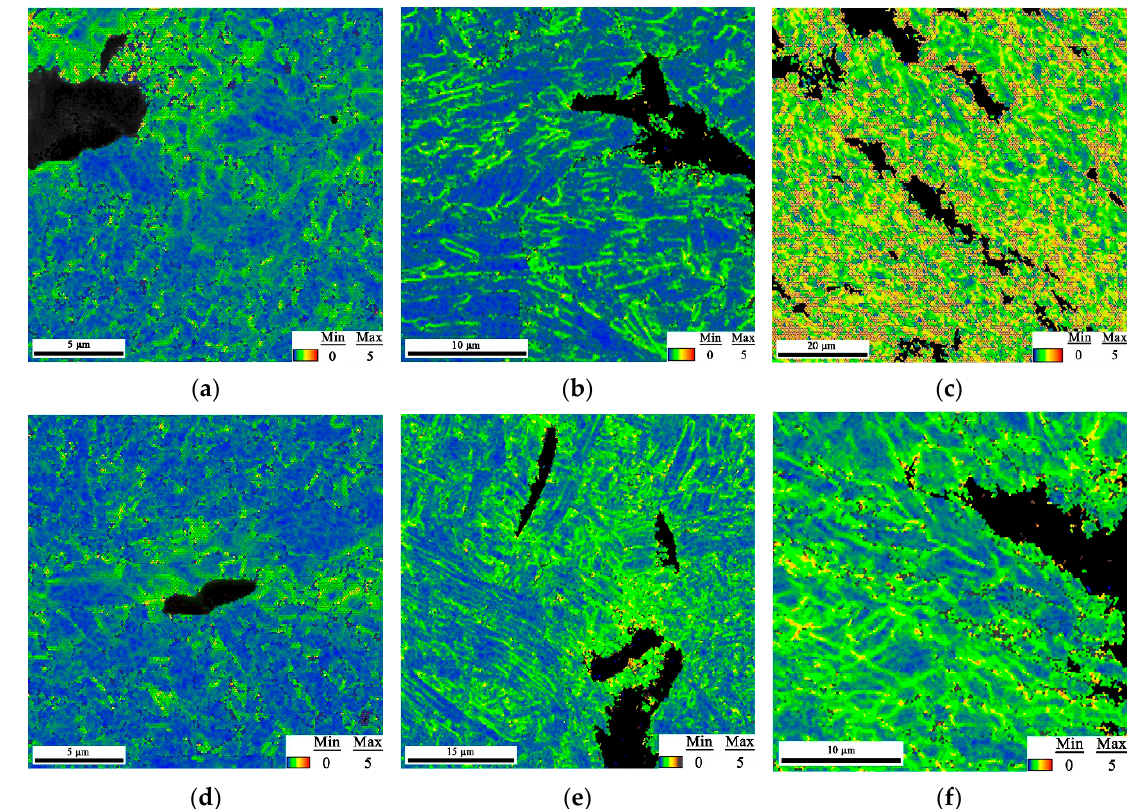
Figure 9. The KAM map of the secondary crack obtained from the welded sample: ( a ) WZ; ( b ) CGHAZ; and ( c ) SCHAZ, and PWHT sample: ( d ) WZ; ( e ) CGHAZ; and ( f ) SCHAZ.